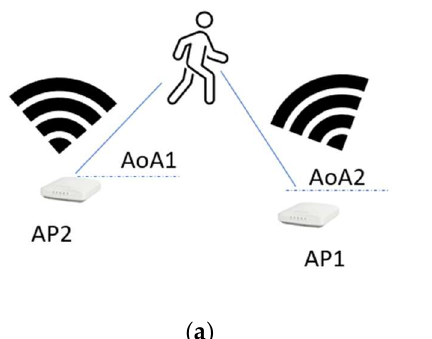
Figure 13. WiFi sensing with different situations; ( a ) using two APs and measuring Angle of Arrival (AoA); ( b ) Using 3 APs and measuring Time of Fly (ToF).